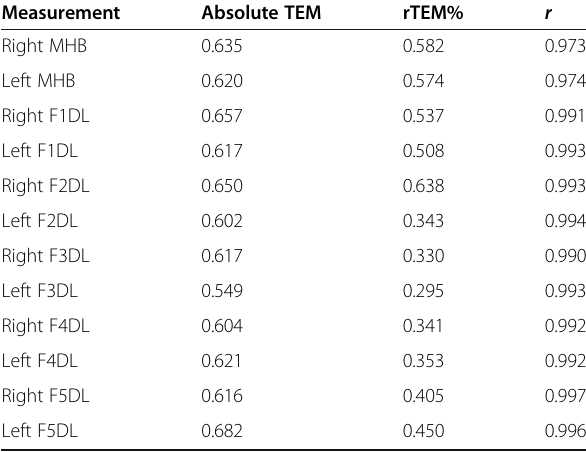
Table 1 Intra-observer error measurement Measurement